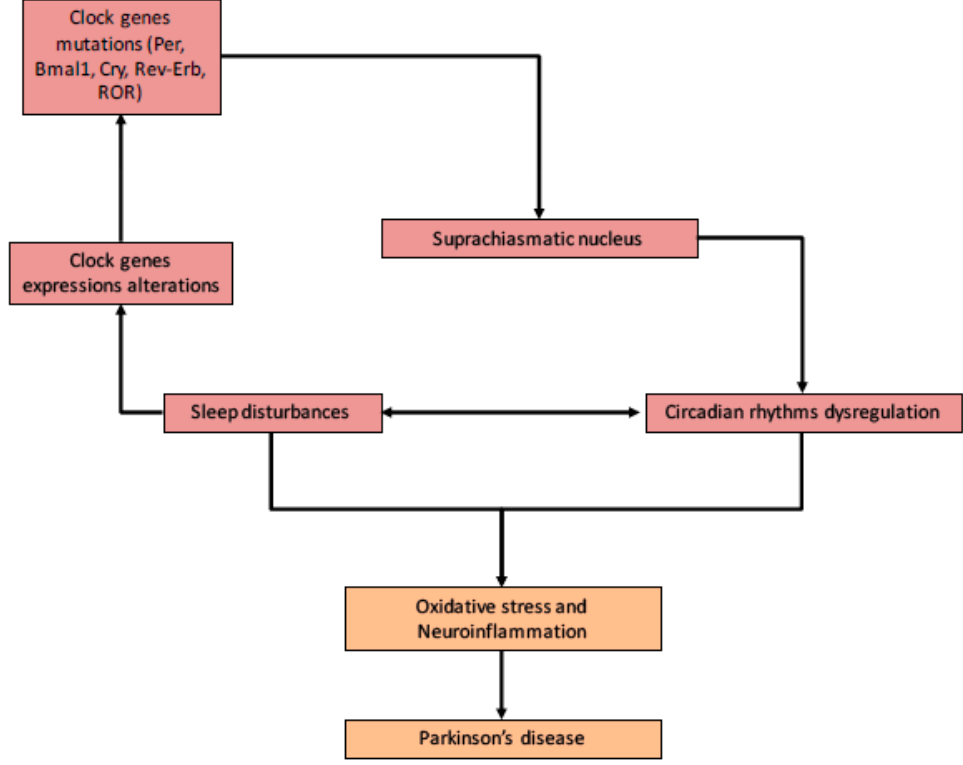
Figure 2. Circadian rhythms (CRs) and Parkinson’s disease (PD). Relationship between PD, CRs, oxidative stress, and neuroinflammation. Alterations in clock genes and the melatonin pathway contribute to the dysregulation of circadian sleep rhythmicity. CRs deregulation leads to metabolism alterations (i.e., oxidative stress) and neuroinflammation contributing to PD.